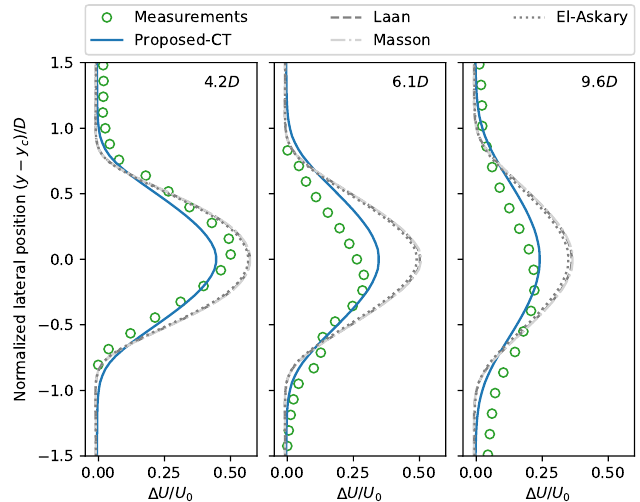
Figure 15. Same as Figure 13 but for Danwin 180 kW wind turbines. All turbulence models are combined with actuator disk model (AD) based on thrust coefficient.